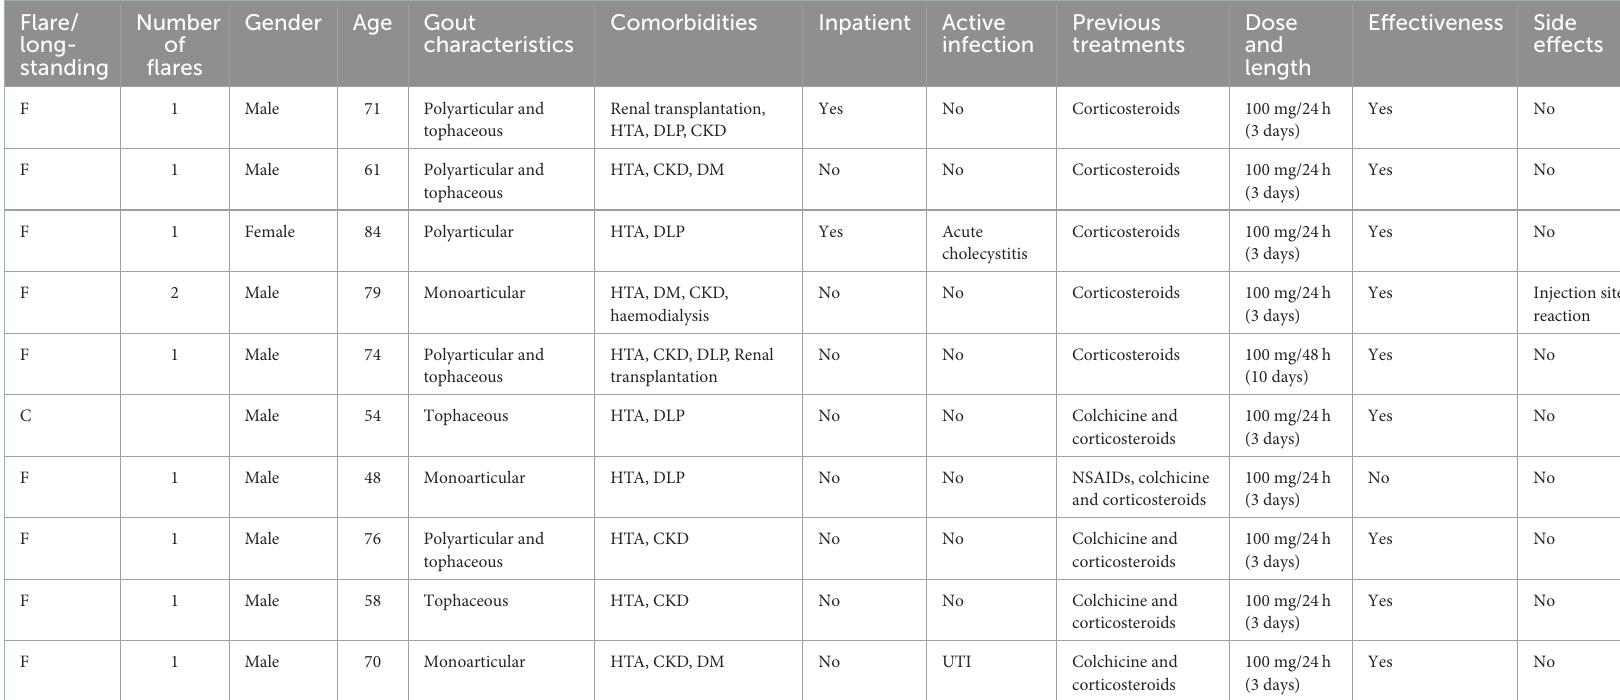
TABLE 1 Demographic and clinical characteristics of our 10 cases and anakinra